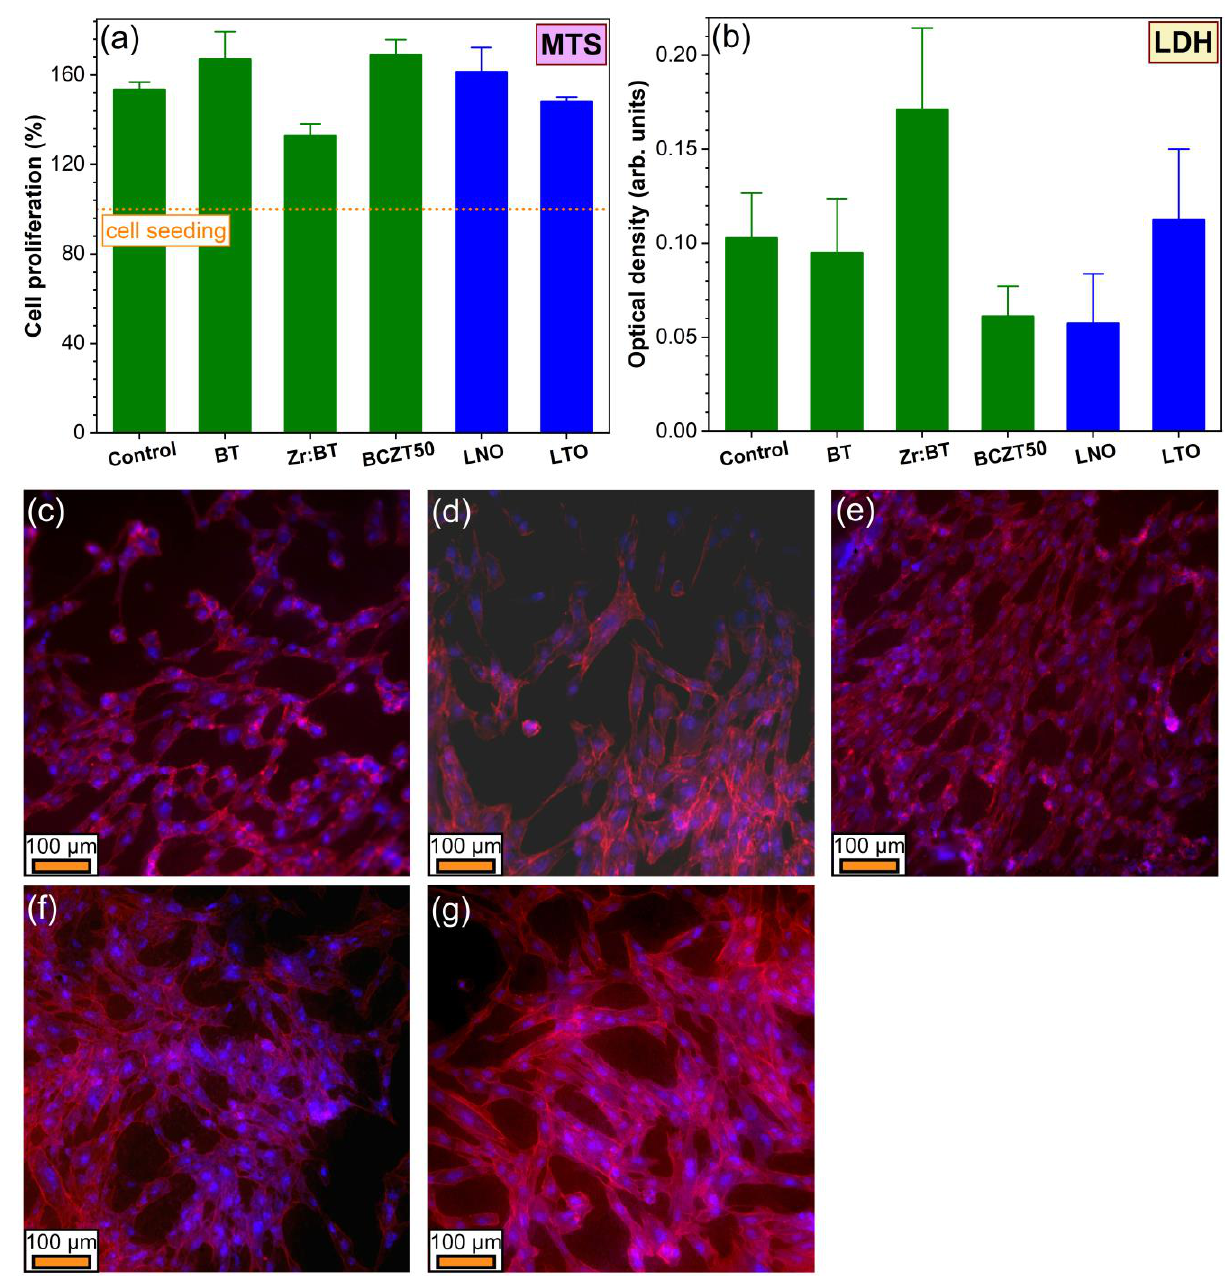
Figure 9. ( a ) hFOB 1.19 cell proliferation of the sintered ceramics, as assessed by an MTS assay performed after 36 h of culturing; ( b ) cytotoxicity of the investigated piezoceramics, as inferred by an LDH test after 36 h of culturing; ( c – g ) morphology of hFOB 1.19 cells after 36 h of culturing on the surface of the ( c ) BT; ( d ) Zr:BT; ( e ) BCTZ50; ( f ) LNO; and ( g ) LTO disks, as evidenced by epifluorescence microscopy. The actin cytoskeleton is stained with red (Alexa Fluor ™ 546 phalloidin), whilst the cell nuclei are counterstained with blue (DAPI).